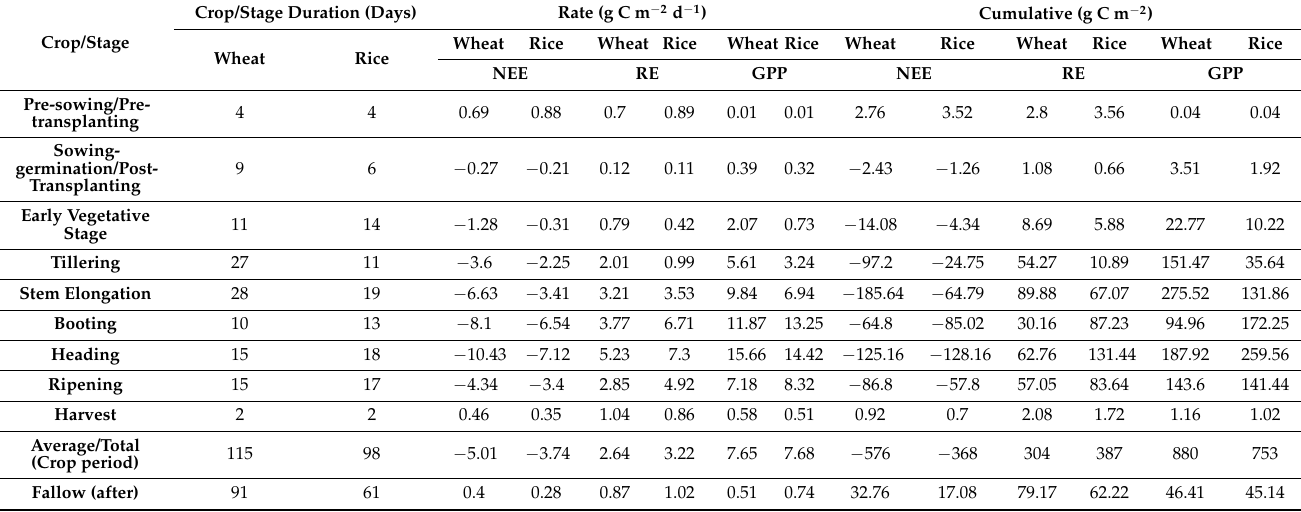
Table 1. NEE, RE and GPP at different rice and wheat growing